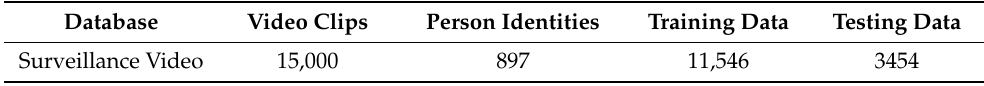
Table 1. The statistics of surveillance video